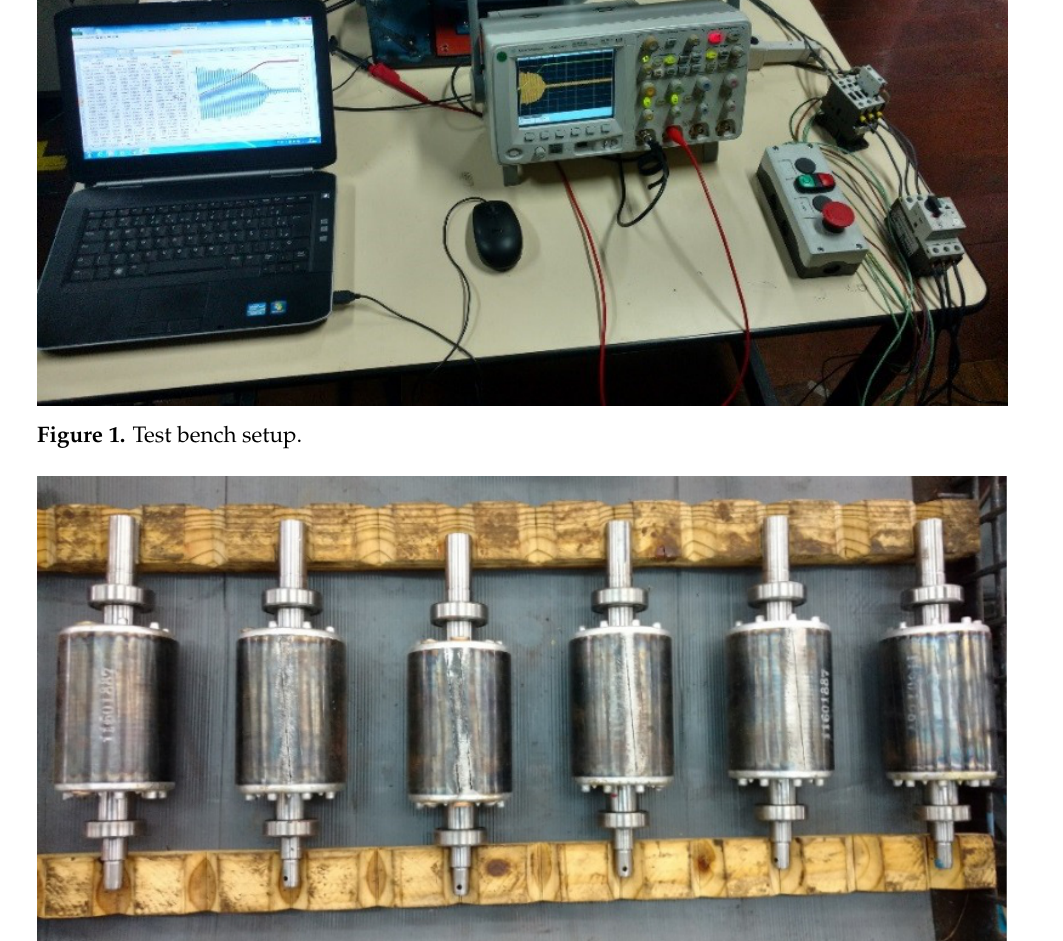
Figure 2. Rotors with controlled failures, manufactured especially for the study. During a direct start-up with no-load, the transient time of the motor is too short to measure low frequencies. It is recommended that the start-up time should be increased until at least ten periods of the center frequency of the Gaussian filter. For this study, a Diesel generator, isolated from the grid, was used to drive the motor at a lower voltage (90 V-60 Hz) with low THD (total harmonic distortion). The start-up takes 0.7 s, allowing 14 periods of 20 Hz harmonic (Figure